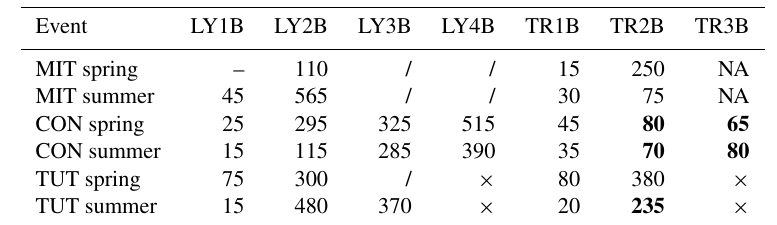
Table 5. Time to 20% event water fraction (min) for all flow components and all sprinkling experiments. The “–” indicates that time to 20% event water fraction could not be calculated due to missing data at the beginning of the event (MIT in spring), × indicates that this LY or TR did not exist (TUT), NA indicates that this trench yielded no flow (MIT), and “/” indicates that 20% event water fraction was not reached during the event. Numbers in bold indicate that the time to 20% event water fraction was shorter than the time to 20% rise in SSF (see Table